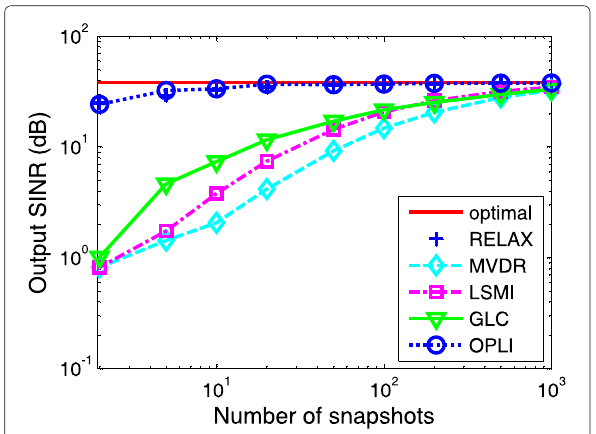
Fig. 2 Output SINR versus the number of